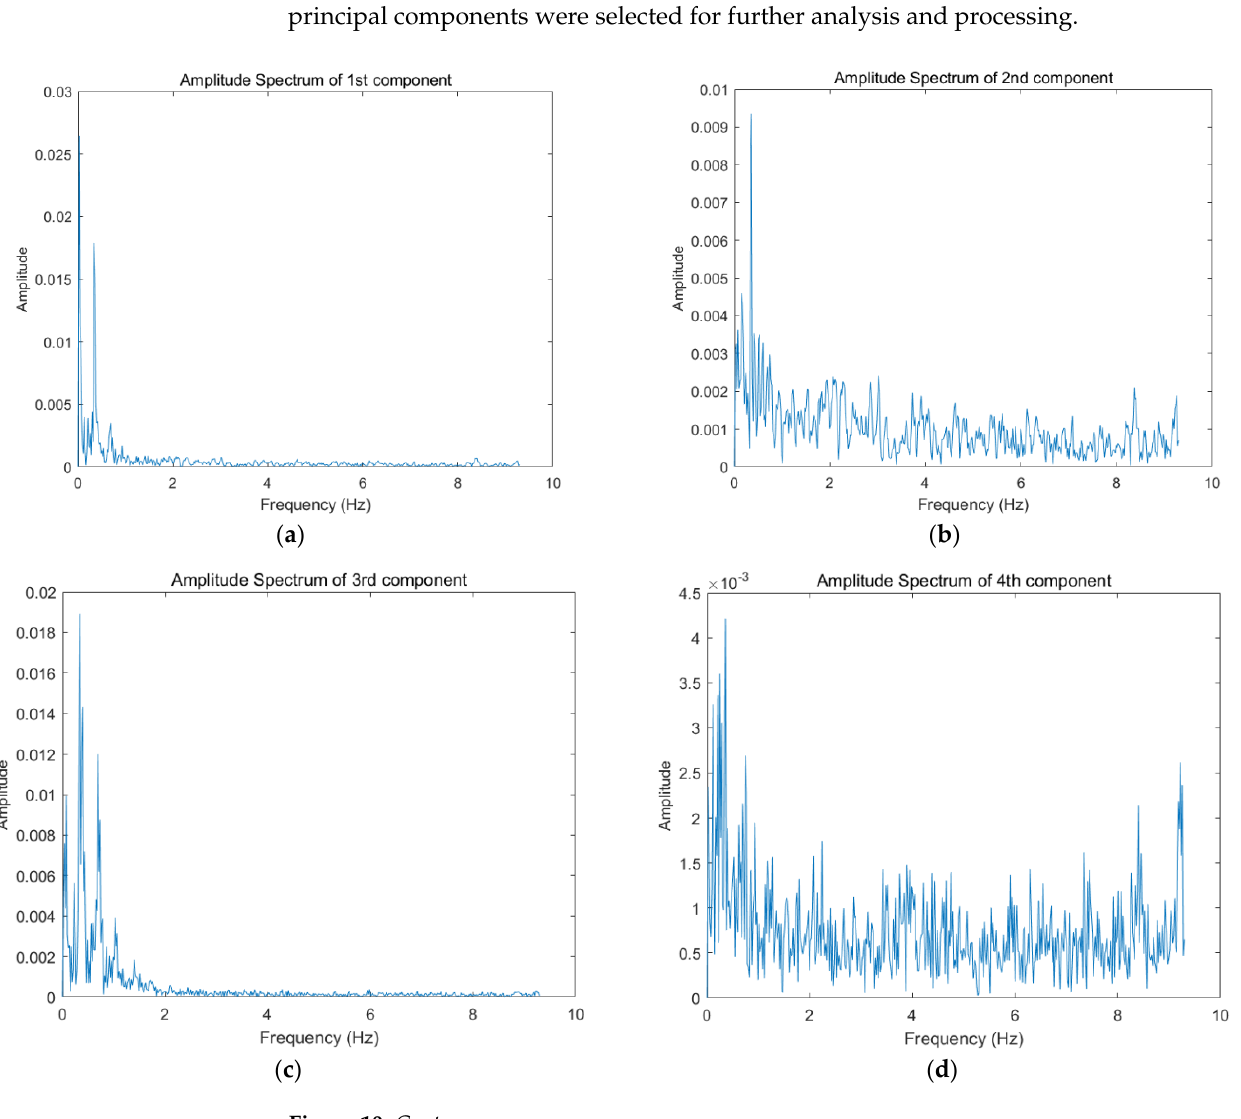
Figure 9. Temporal and spatial eigenvectors for the first six order principal components: ( a ) First spatial eigenvector; ( b ) first temporal eigenvector; ( c ) second spatial eigenvector; ( d ) second tem- poral eigenvector; ( e ) third spatial eigenvector; ( f ) third temporal eigenvector; ( g ) fourth spatial ei- genvector; ( h ) fourth temporal eigenvector; ( i ) fifth spatial eigenvector; ( j ) fifth temporal eigenvec- tor; ( k ) sixth spatial eigenvector; ( l ) sixth temporal eigenvector.